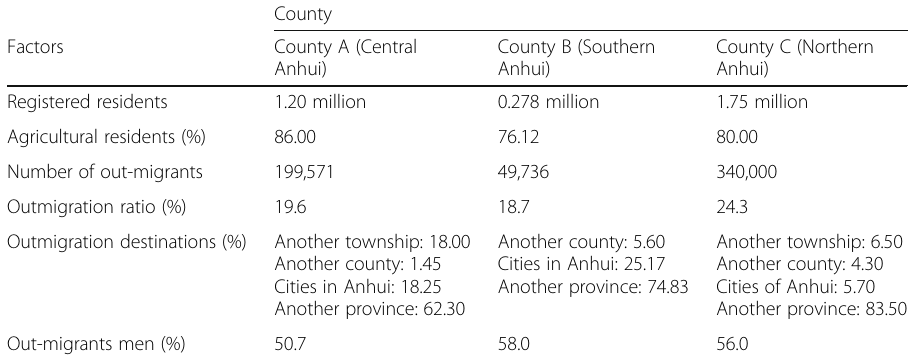
Table 8 Sample counties ’ demographic factors